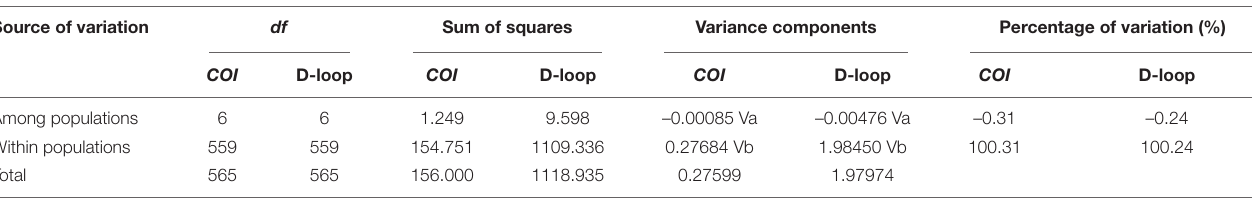
FIGURE 5 | NJ tree of the D-loop region of G. przewalskii based on Kimura-2-parameter model. The numbers at the nodes represent the bootstrap values. TABLE 5 | Analysis of molecular variance (AMOVA) for the G. przewalskii